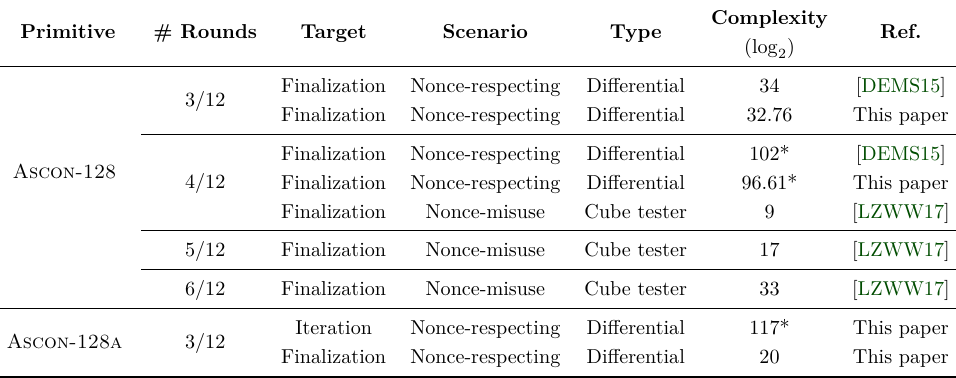
Table 8: Forgery attacks against round-reduced Ascon-128 and Ascon-128a .